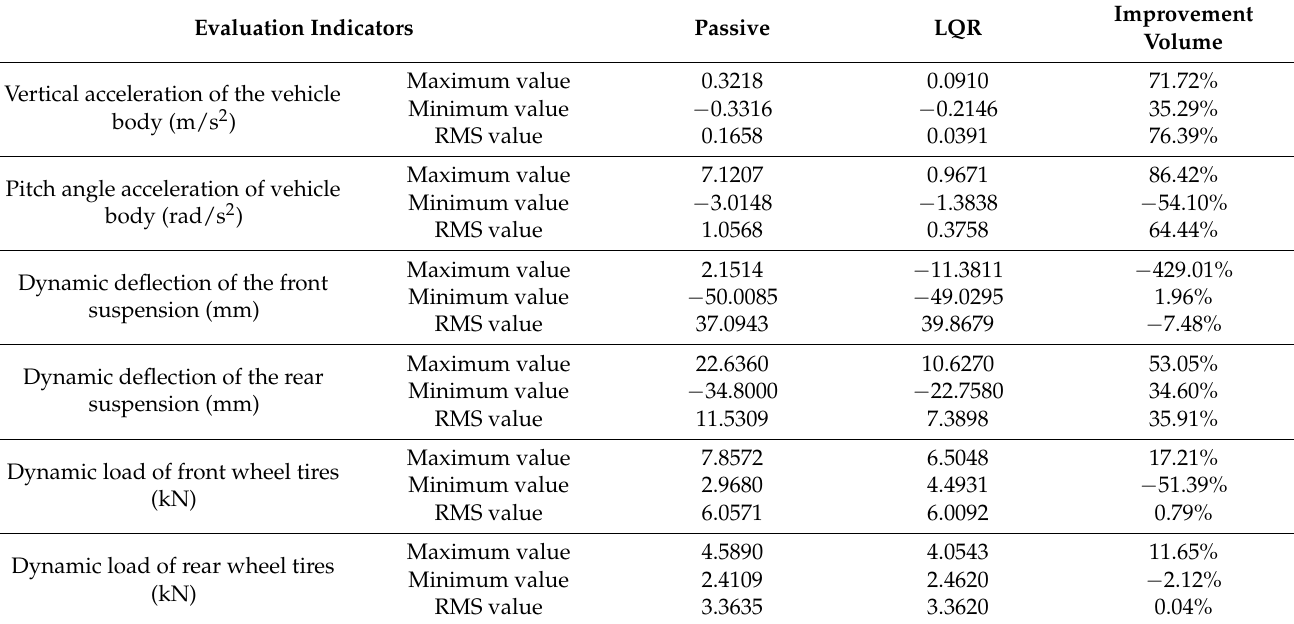
Table 11. Comparison of maximum, minimum, and RMS values for emergency braking